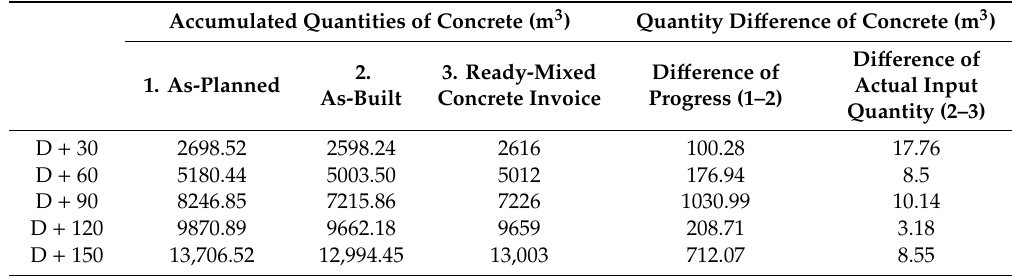
Table 3. The difference in the input quantity (as-planned, as-built, and actual input quantity). Accumulated Quantities of Concrete (m 3 )